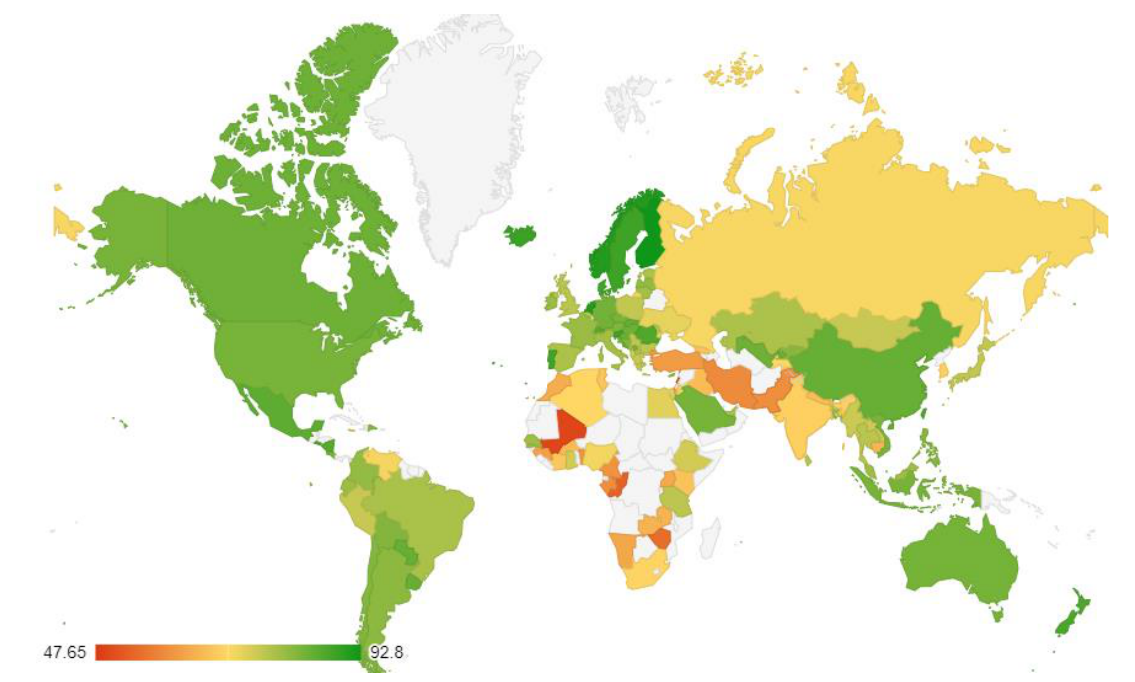
Figure 1. Balance index around the world. The grey color indicates no available data.